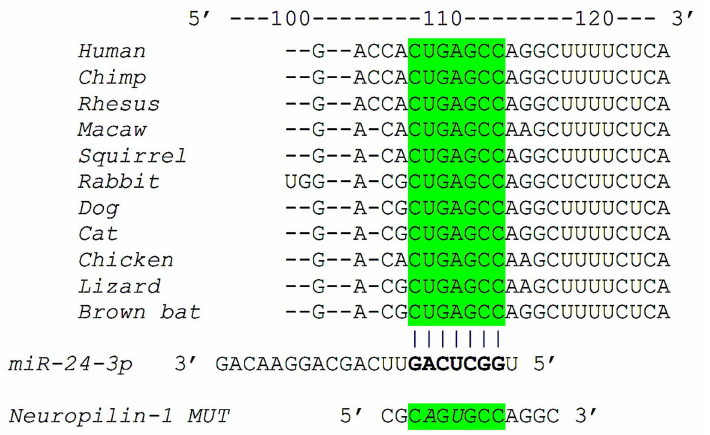
Figure 1. Identification of miR-24 as modulator of Neuropilin-1. Complementary nucleotides between the target region of Neuropilin-1 3 (cid:48) -UTR (in green) and hsa-miR-24-3p are highly conserved across different